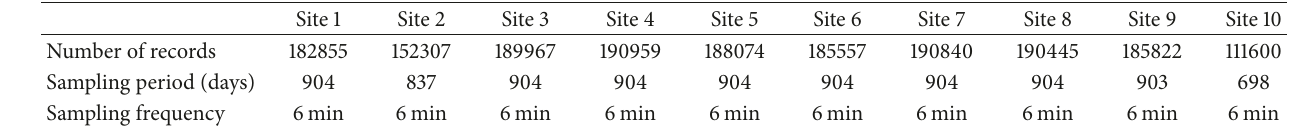
Table 1: Sampling information.